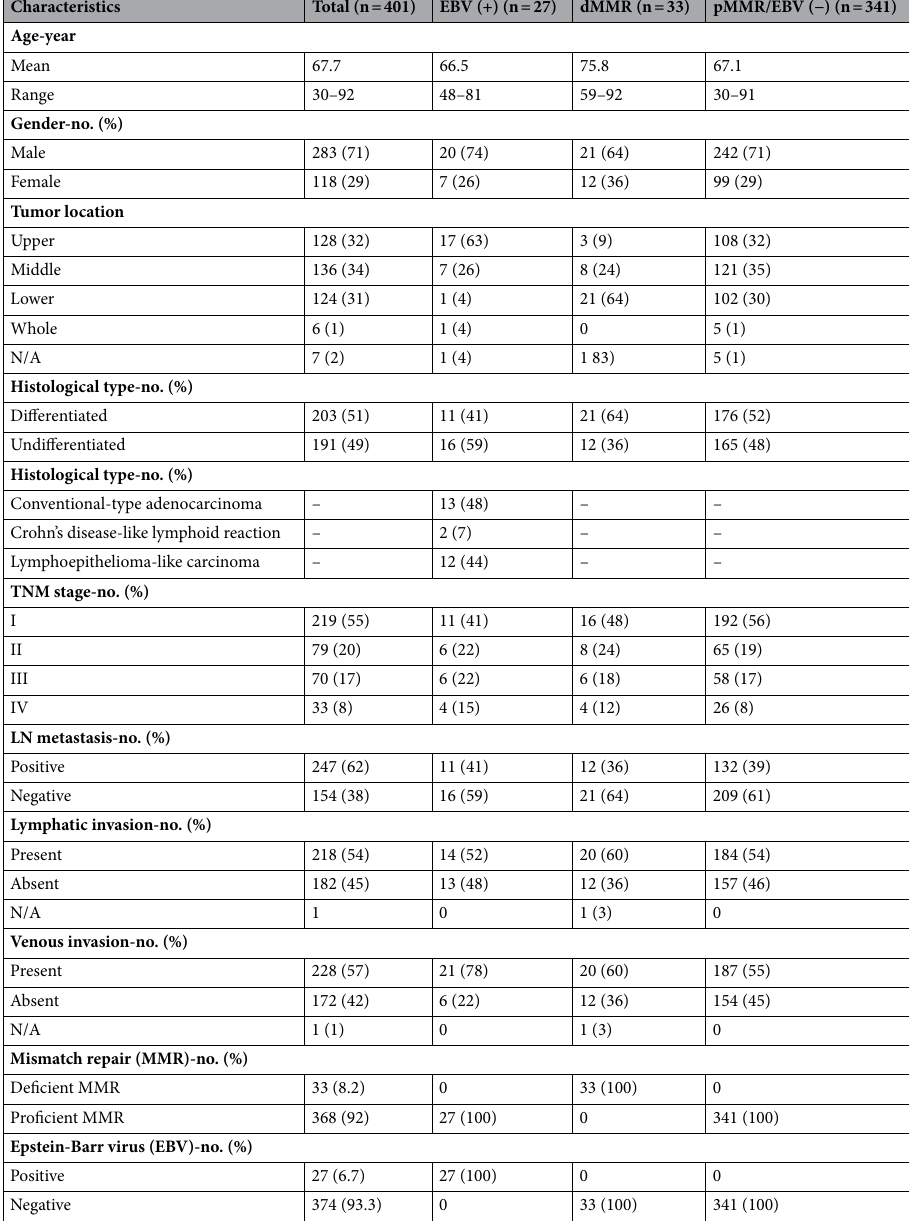
Table 1. Clinicopathological characteristics of gastric cancer patients from FMU